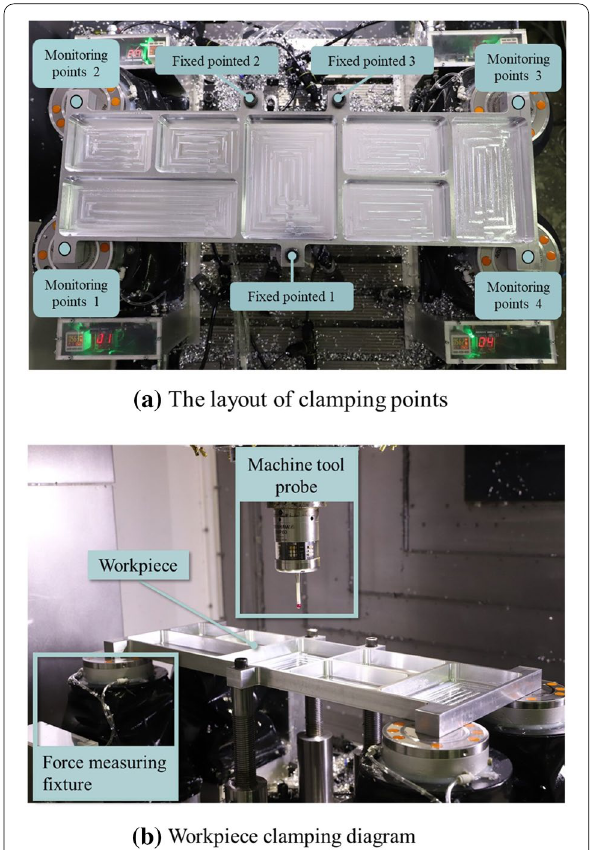
Figure 11 Machining environment and workpiece clamping layout diagram